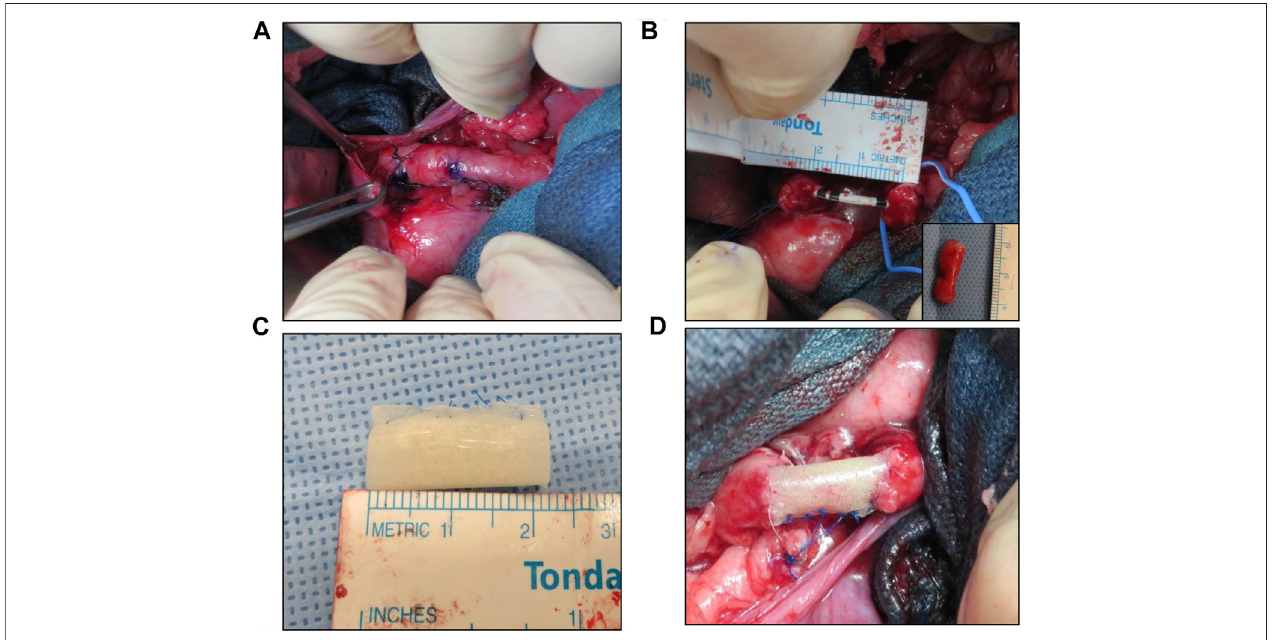
FIGURE 1 | Porcine tubular ureteroplasty model. (A) Exposure of proximal ureter and marking of target reconstructive area. (B) Creation of tubular ureteral defect and stent placement. Inset denotes excised tissue. (C) Tubular BLSF graft prior to implantation. (D) BLSF graft anastomosed into ureteral defect. BLSF, bi-layer silk fi broin